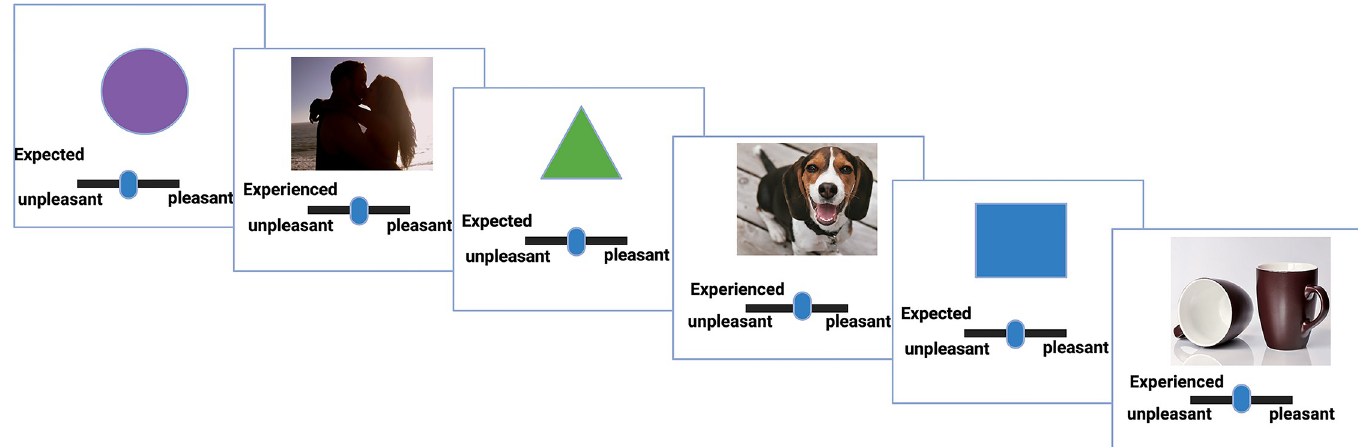
Fig 1. Task overview demonstrating cues and example images for erotic, pleasant, and neutral